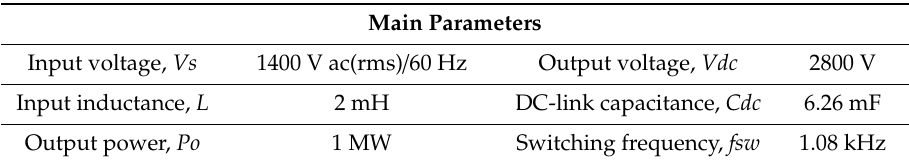
Table 2. Parameters used in simulation.